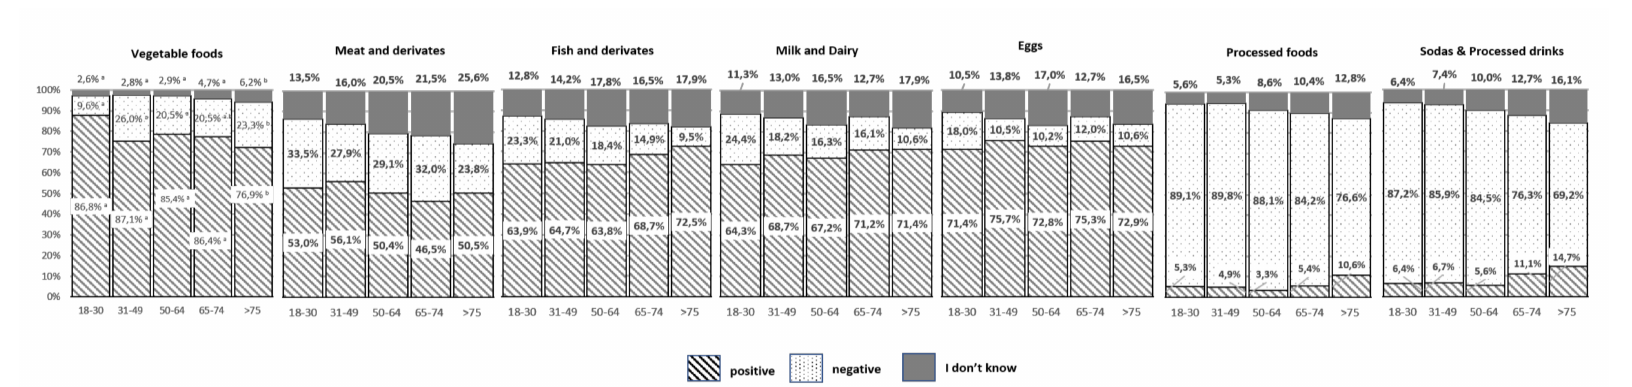
Figure 3. Perceived impact on sustainability of the di ff erent food groups in Spanish adult population, by gender. * denotes statistical di ff erences between women and men ( p ≤ 0.05). Samples size were: Men n = 882; women n = 1170.